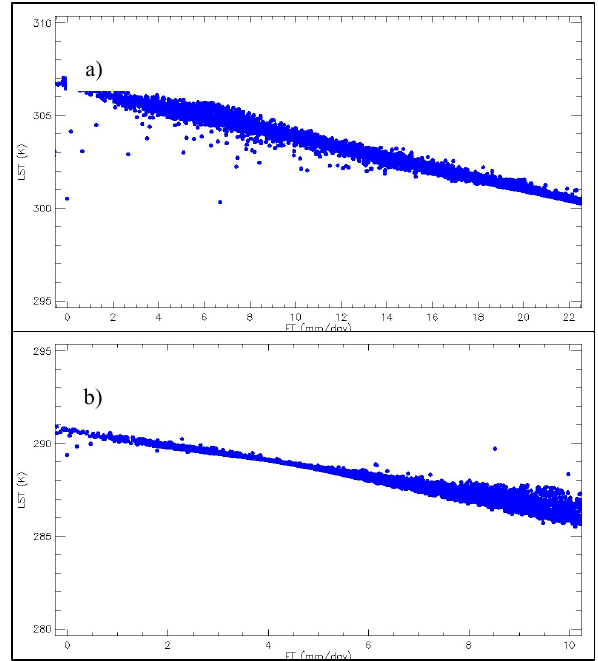
Figure 2. Land Surface Temperature versus Evapotranspiration (mm/day) for a) DOY 349 and b) DOY